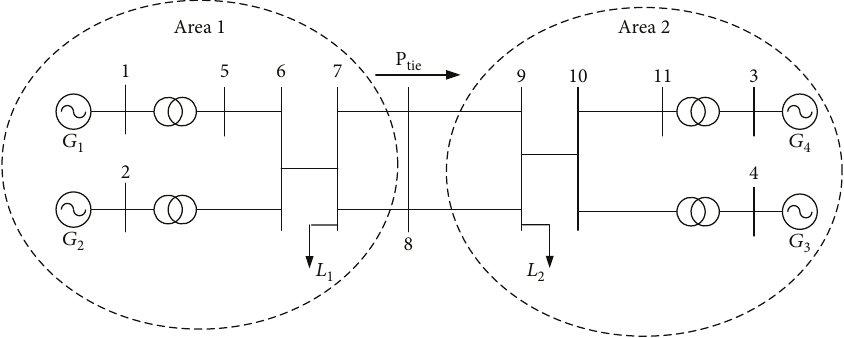
Figure 1: Two-area four-machine test power